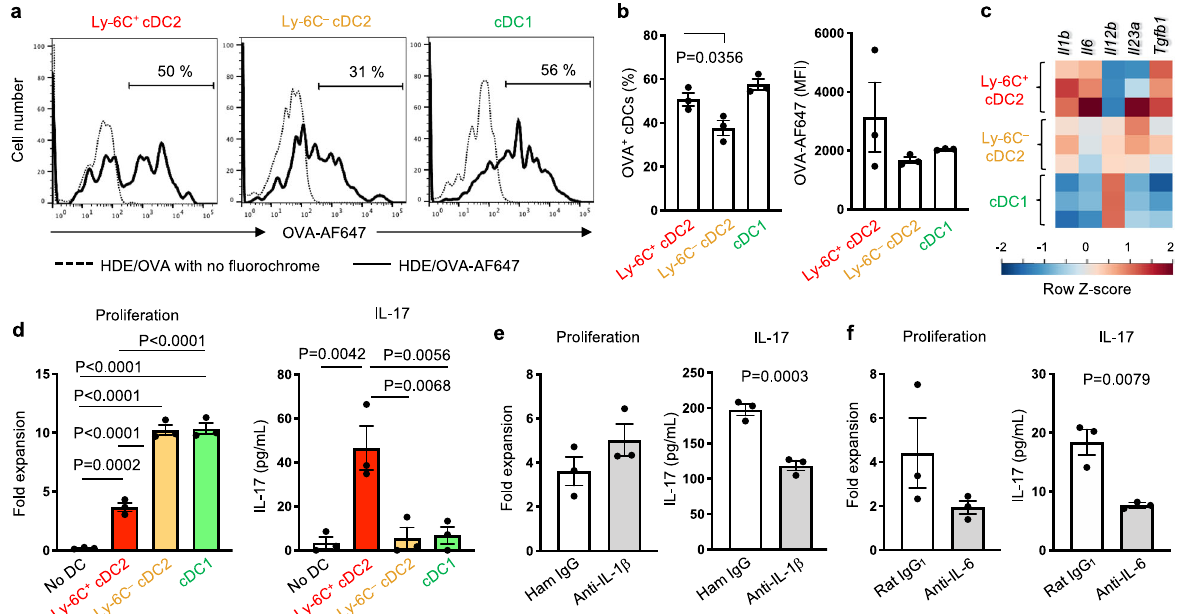
Fig. 3 Ly-6C + CD11b + cDC2 stimulate Th17 cell differentiation. a , b Flow cytometric analysis of lung cDCs harvested 16 h after inhalation of AF647- labeled OVA with HDE. Representative histograms ( a ) and compiled data ( n = 3) ( b ) showing OVA-AF647 uptake. The gating strategy is shown in Supplementary Fig. 6a. Data were analyzed by ordinary one-way ANOVA with Dunnett ’ s multiple comparison. Data are presented as mean ± SEM. c Heatmap of RNA-Seq data showing expression of genes promoting Th17 or Th1 differentiation. Expression levels are indicated by color difference as shown in bottom bar. d Proliferation of and IL-17 production from CD4 + T cells stimulated by lung cDCs. IL-17 in the supernatant of cultured CD4 + T cells was measured by ELISA. Data were analyzed by ordinary one-way ANOVA with Tukey ’ s multiple comparison test ( n = 3). Data are presented as mean ± SEM. e , f Proliferation of and IL-17 production from CD4 + T cells stimulated by Ly-6C + cDC2 in the presence of anti-IL-1 β ( e ) or anti-IL-6 ( f ) neutralizing Abs or isotype control. IL-17 in the supernatant was measured by BioPlex. Data were analyzed by unpaired two-tailed t -test ( n = 3). Data are presented as mean ± SEM. A representative result from two independent experiments is shown. Source data are provided as a Source Data fi